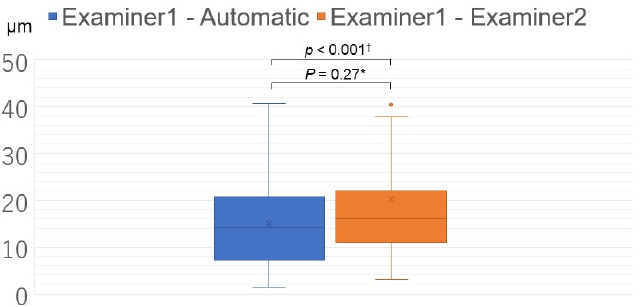
Figure 5. Comparison between the distance between macular hole (MH) center measurements obtained manually and automatically (Examiner 1—Automatic) and the distance between both manually obtained MH center measurements (Examiner 1—Examiner 2). * Welch t -test; † Non- inferiority test with the margin set at 15 µm.